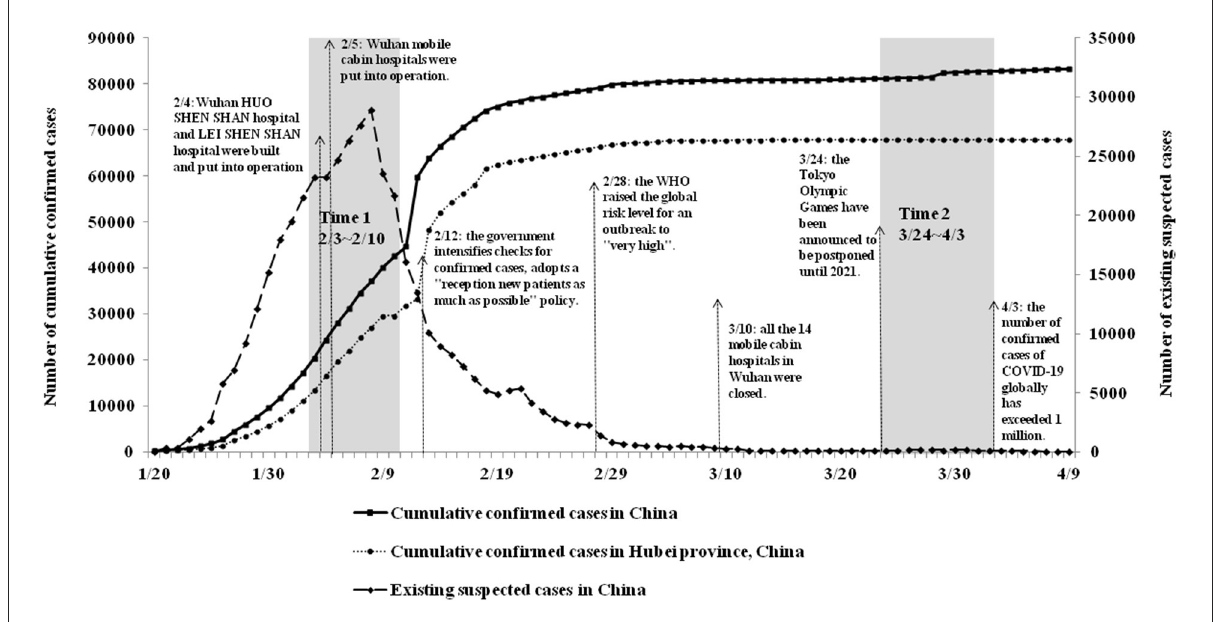
FIGURE1 The details of study design and sample